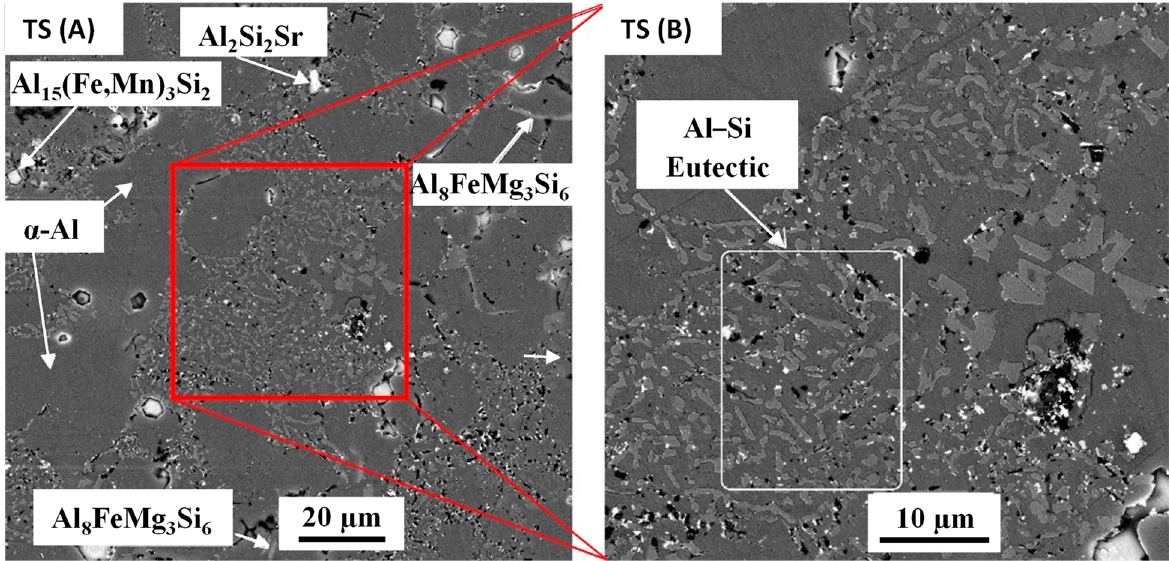
Figure 9. Micrograph showing the TS specimen: ( A ) representative primary phases; ( B ) close-up of the red box region in ( A ).